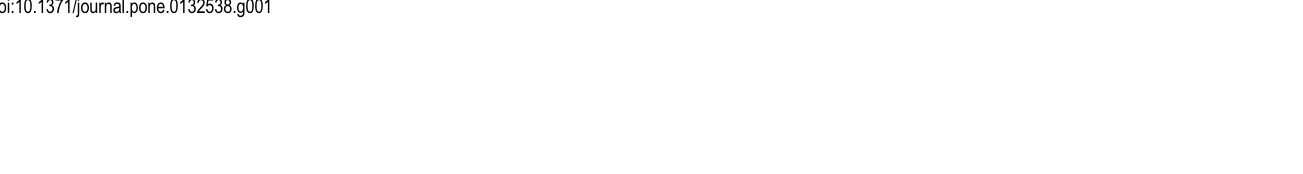
PLOS ONE | DOI:10.1371/journal.pone.0132538 July 6,